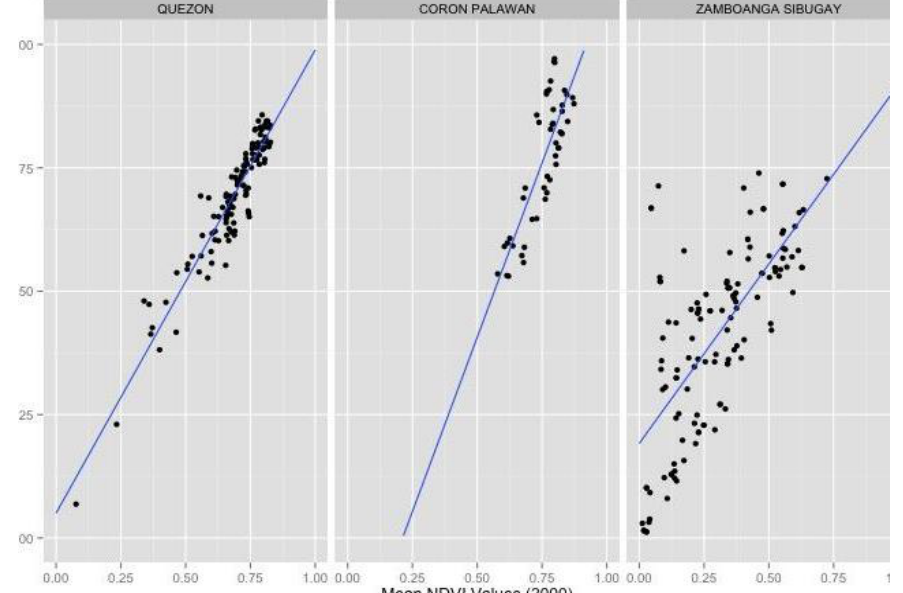
Figure 4. Scatter plot of the mangrove areas showing the mean NDVI values from Landsat 2000 and 2013 global mosaic data by Hansen et al. 2013. Table 1. Field validated areas in Palawan (Coron), Quezon (Infanta) and Zamboanga Sibugay (Payao) as seen on the different